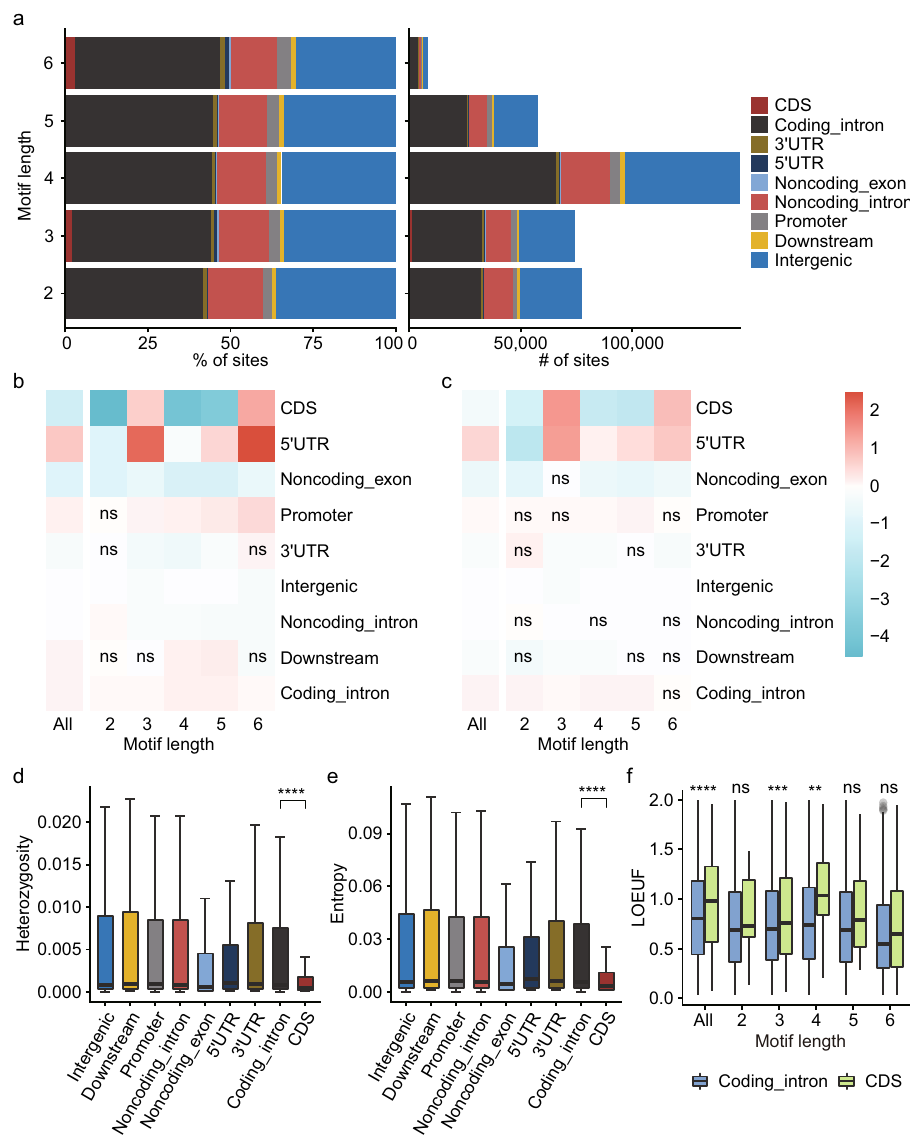
>0.05). d , e Heterozygosity ( d ) and entropy ( e ) of pSTR loci ( n =366,013) in dif- ferentgenomicregions. f LOEUFscoresofprotein-codinggenesenclosingpSTRsin the CDS ( n =282) and introns ( n =11,349). For Figure d – f , horizontal lines indicate the median, boxes spanfrom the lower quartile (the 25th percentiles) to the upper quartile (the 75th percentiles), and whiskers extend to points that are within 1.5 ×IQR (interquartile range) from the upper or the lower quartiles; the two-sided Wilcoxon rank-sum test was used to compute P values. ns, P value ≥ 0.05; **